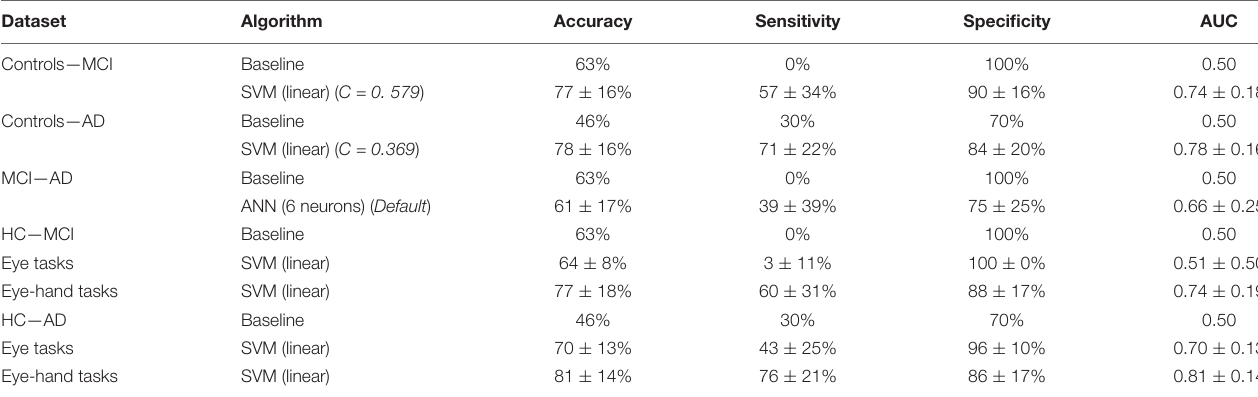
TABLE 6 | Performance of the best performing algorithm, with hyperparameter selection results, for the classification of controls and MCI Patients, controls and AD Patients, and MCI Patients and AD patients with all data and separately for eye tasks and eye-hand tasks. Dataset Algorithm